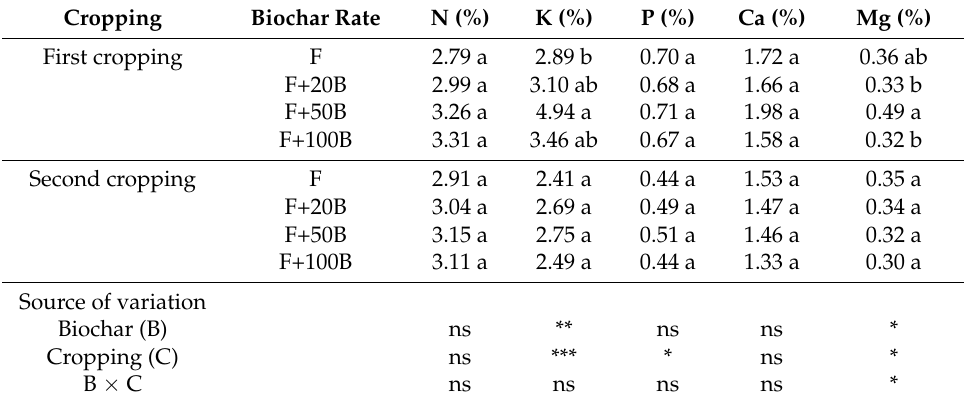
Table 2. The leaf nutrient N, P, K, Ca and Mg of sesame under the different biochar treatments in different cropping. Cropping Biochar